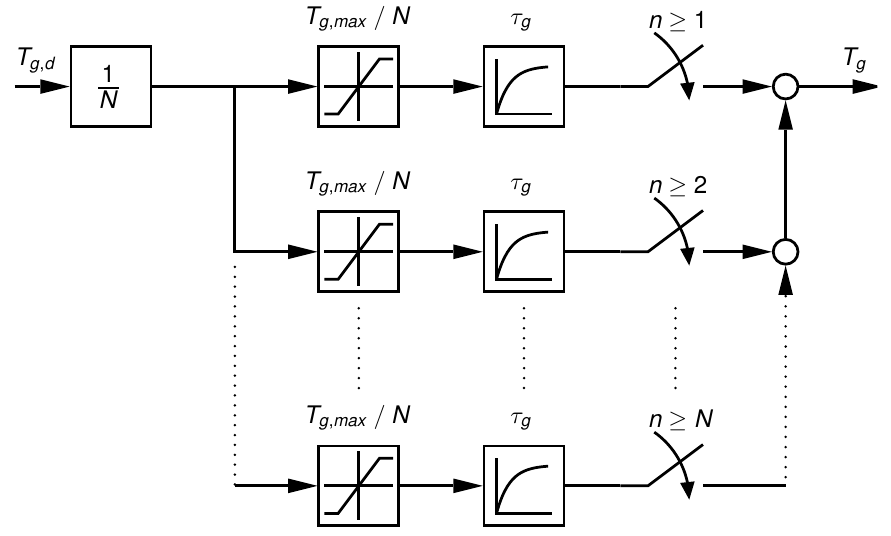
Figure 2. Reduced-order model of multi-generator/converter (Type